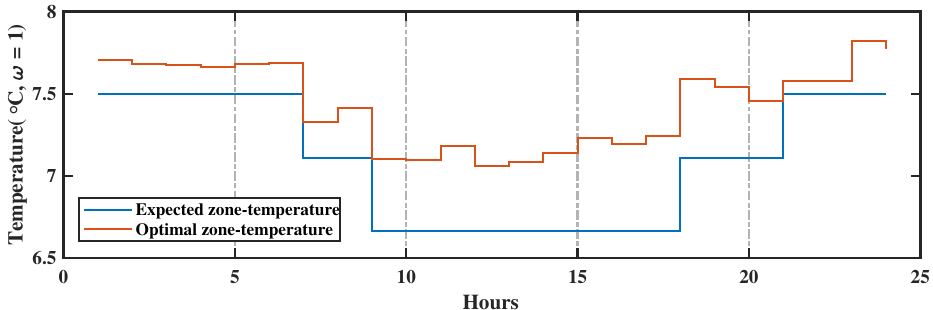
Figure 14. The set-point of zone cooling temperature with ω = 1 in case